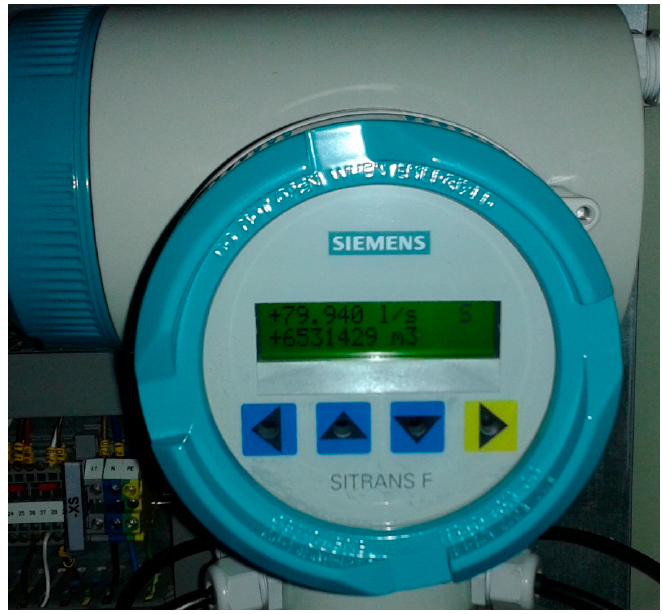
Figure 8. Ultrasonic flowmeter Siemens SITRANS F.